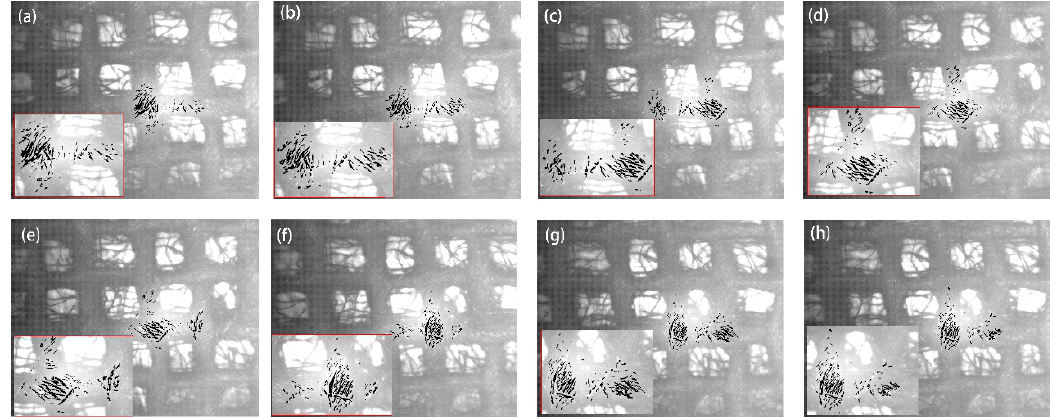
Fig. 7 Dynamic evolution of contact area as a function of displacement ( D ): (a) D = 0.139 mm, (b) D = 0.235 mm, (c) D = 0.333 mm, (d) D = 0.426 mm, (e) D = 0.647 mm, (f) D = 0.93 mm, (g) D = 1.139 mm, and (h) D = 1.399